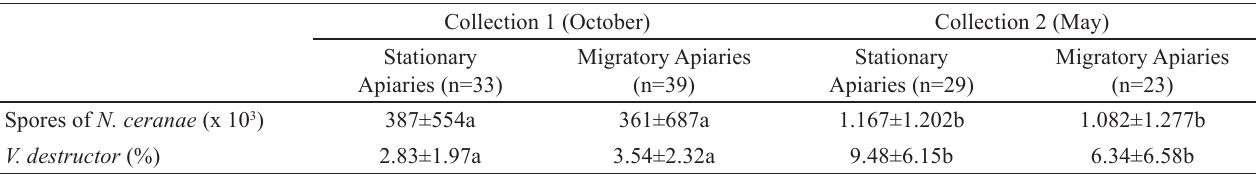
Table 1. Average number of spores of Nosema ceranae x 10 3 per bee (or per milliliter) collected in entrance of the hives, and percentage of infestation of Varroa destructor mites in adult honeybees collected in brood area in two collection periods in stationary and migratory